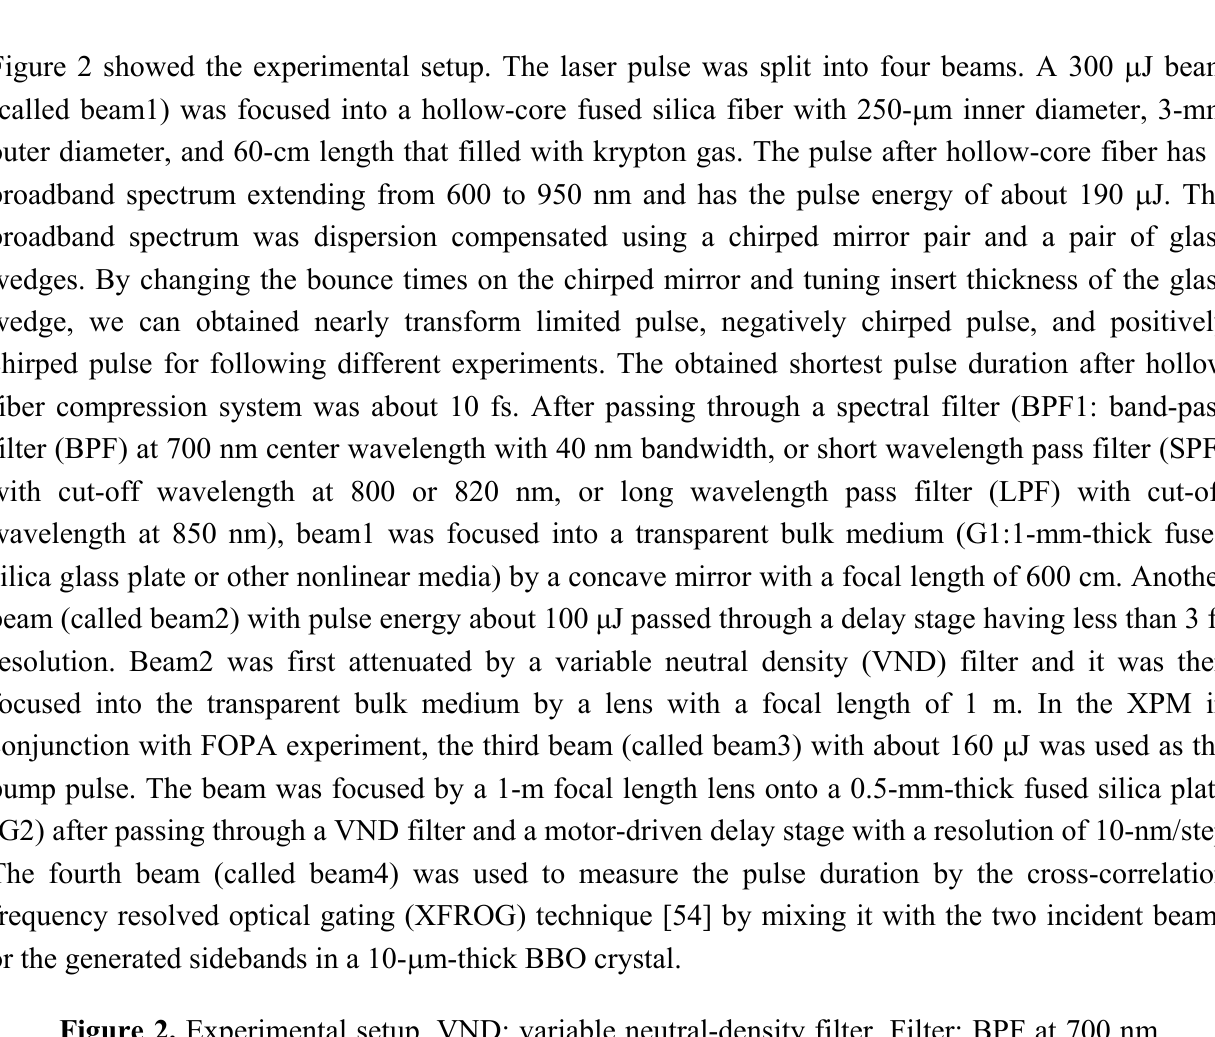
Figure 2. Experimental setup. VND: variable neutral-density filter. Filter: BPF at 700 nm center wavelength with 40 nm bandwidth, or SPF with cut-off wavelength at 800 nm or 820 nm, or long wavelength pass filter (LPF) with cut-off wavelength at 850 nm. G1:1mm-thick fused silica plate or other nonlinear media. G2: 0.5-mm-thick fused silica plate.B1, B2, B3, B4: please refer to the main text in the paper